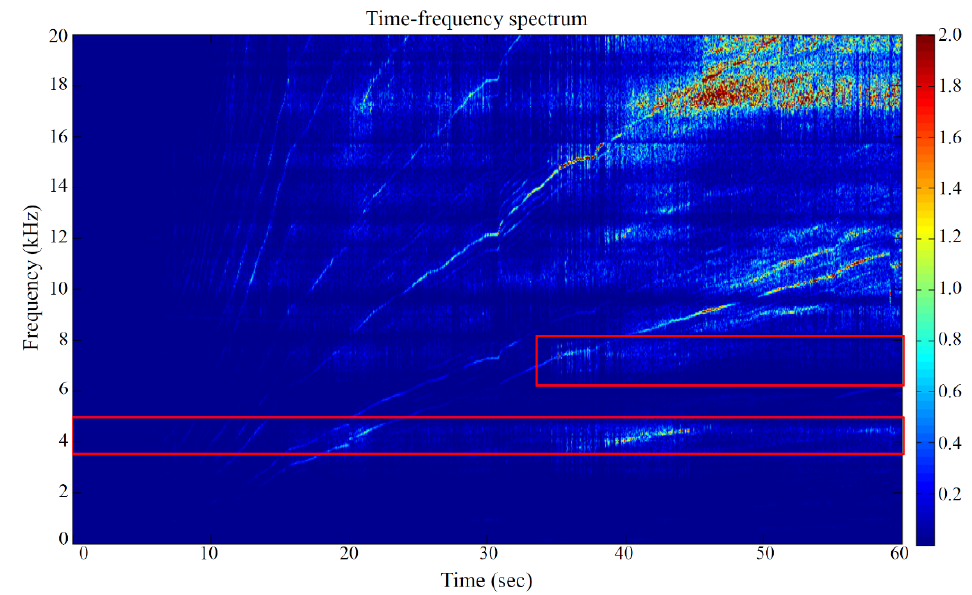
Figure 16. Time-frequency spectrum of gear dynamic